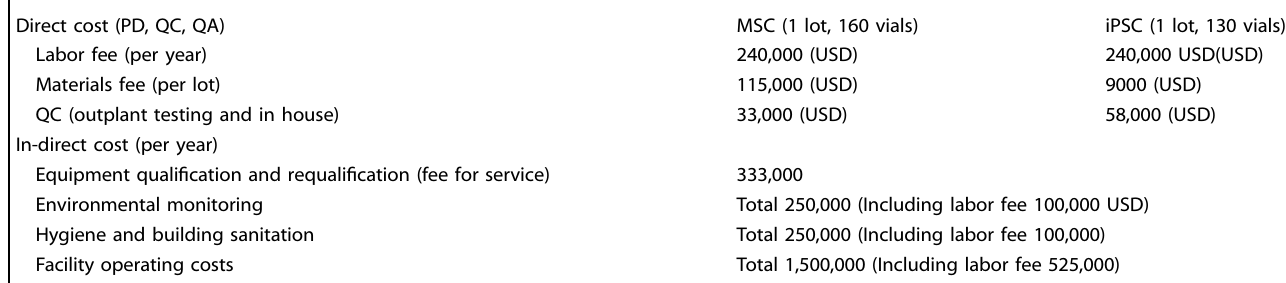
Table 1. An example of the KNIH ’ s costs (approximate